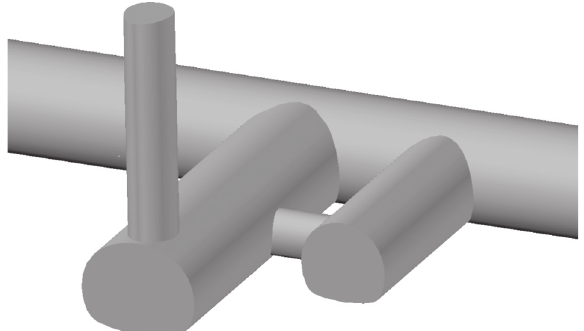
Figure 6: Geometry of tunnel intersection case study.